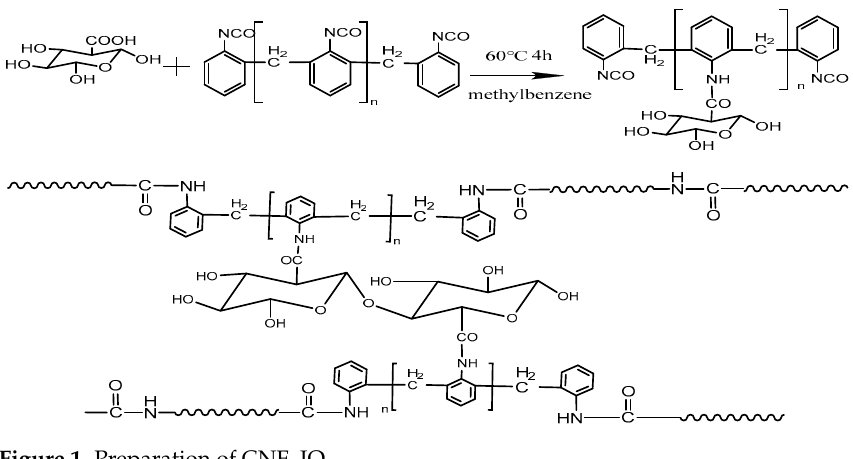
Figure 1. Preparation of CNF–JQ.